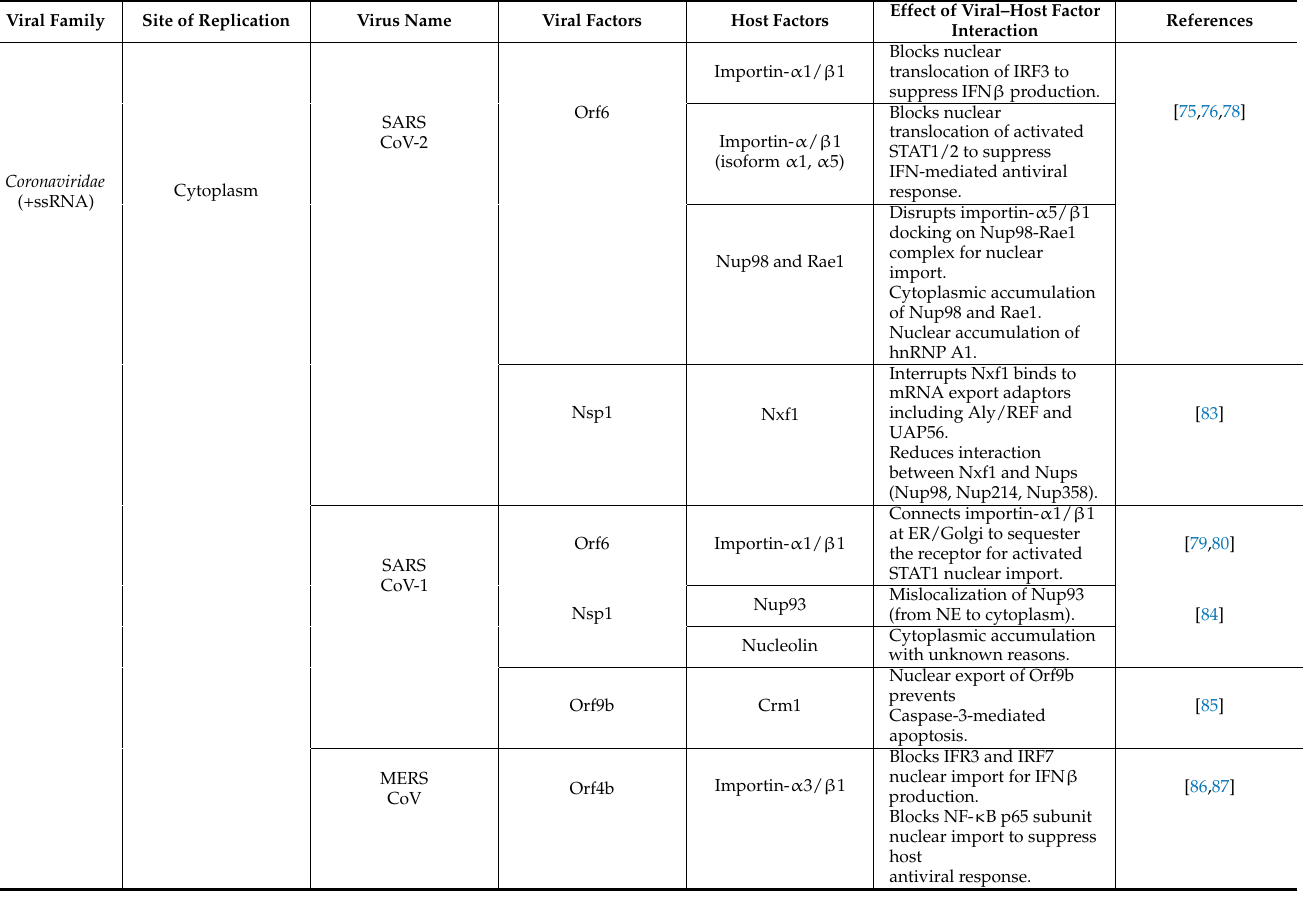
Table 2. Interactions between viral factors and host factors in the hijacking of the host nuclear transport